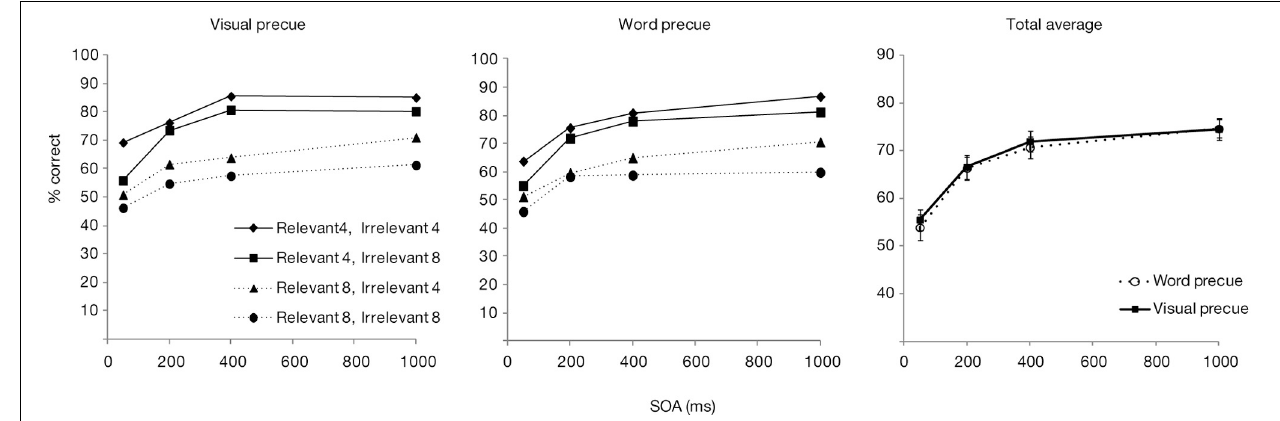
FIGURE 5 | Accuracy scores for Experiment 2, presented as a function of precue type and SOA. Left part of the figure shows accuracy scores separately for the relevant and irrelevant set sizes, right part shows the total averages over the set sizes.